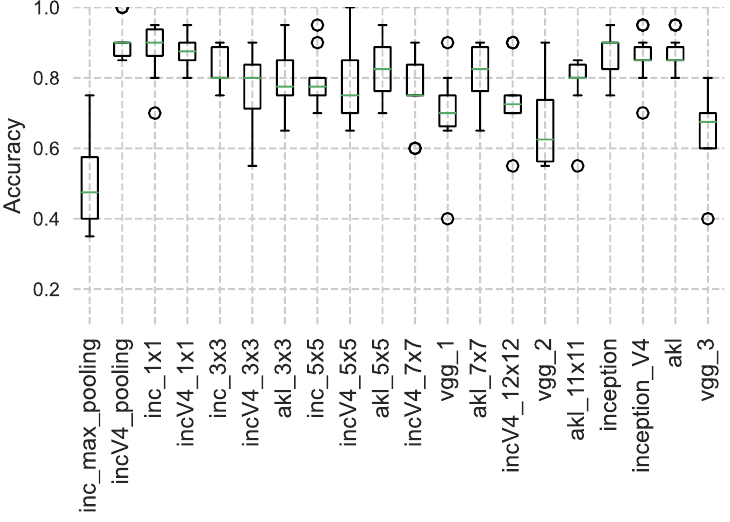
Figure 11. K-NN results using Cat vs Dog dataset. The results of all kernels are comparable as the images are of relatively medium size.